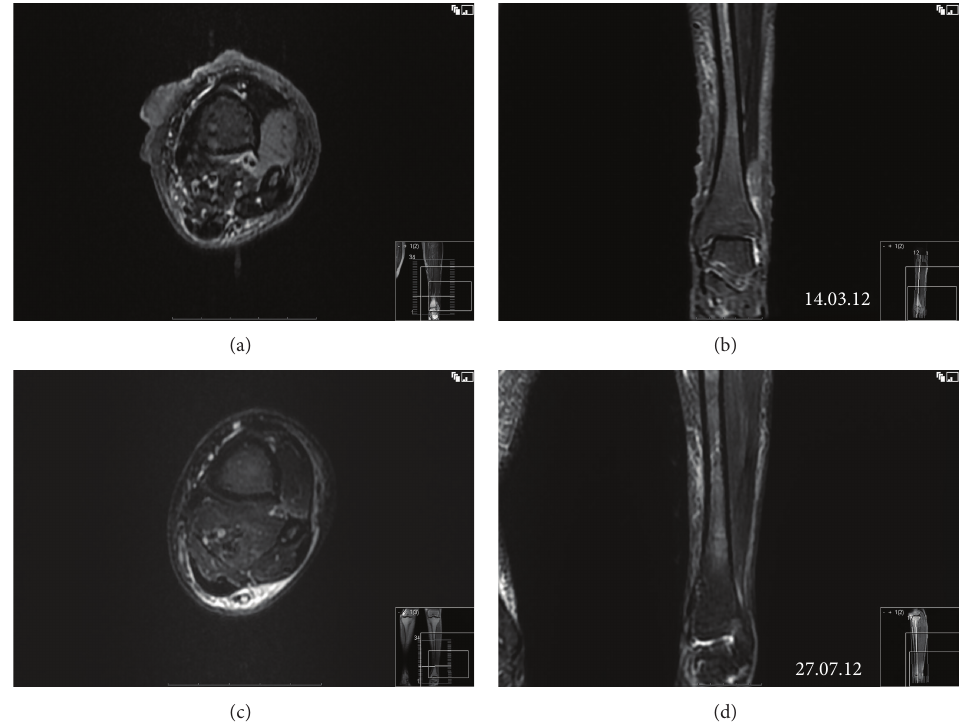
Figure 3: MRI of the left leg. Subcutaneous nodules and myositis of tibialis anterior are shown on T2 fat-saturated axial view (a) and short T1 inversion recovery (STIR) coronal view (b). After treatment, the changes are resolved (c, d).